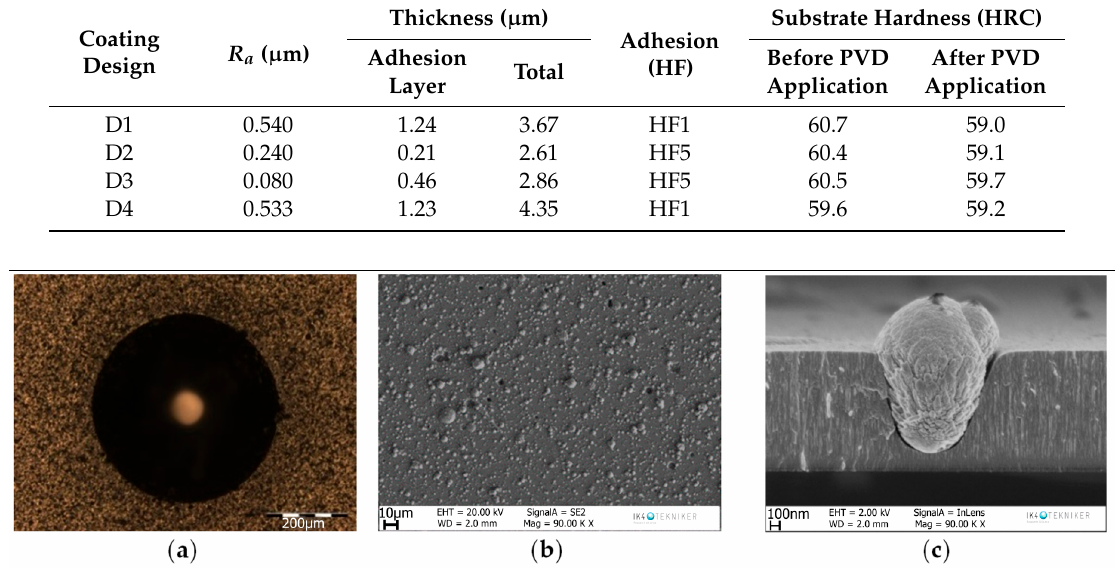
Figure 9. Optical and SEM images for D1 coating; ( a ) adhesion results (optical); ( b , c ) surface, and cross-section micrographs.